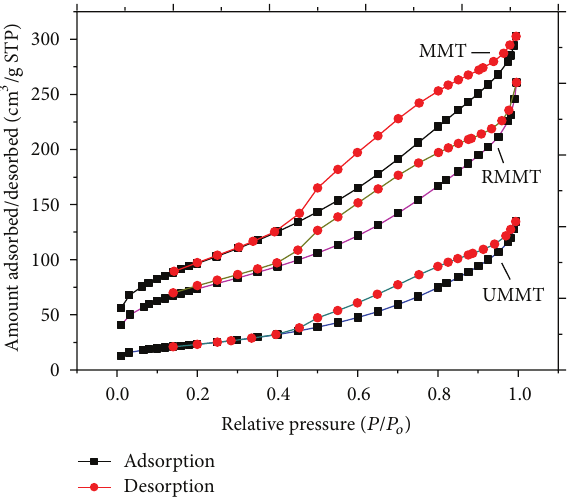
Figure 4: Pseudo-1st and -2nd order sorption kinetic models for intercalation of urea molecules into MMT NP interlayer. Inset: pseudo-2nd order kinetic parameters.